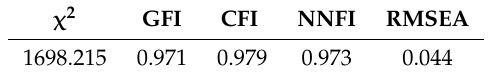
Table 2. Fit indices of measurement model.